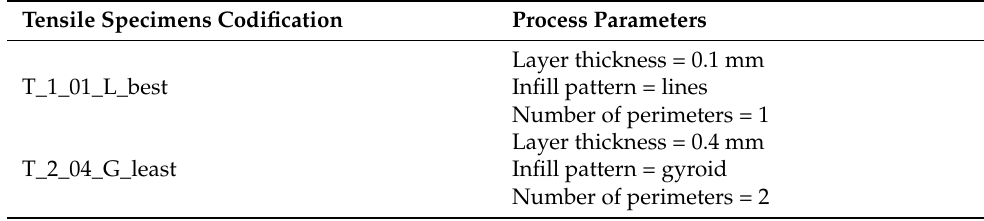
Table 3. 3D-printed parameters for tensile specimens.